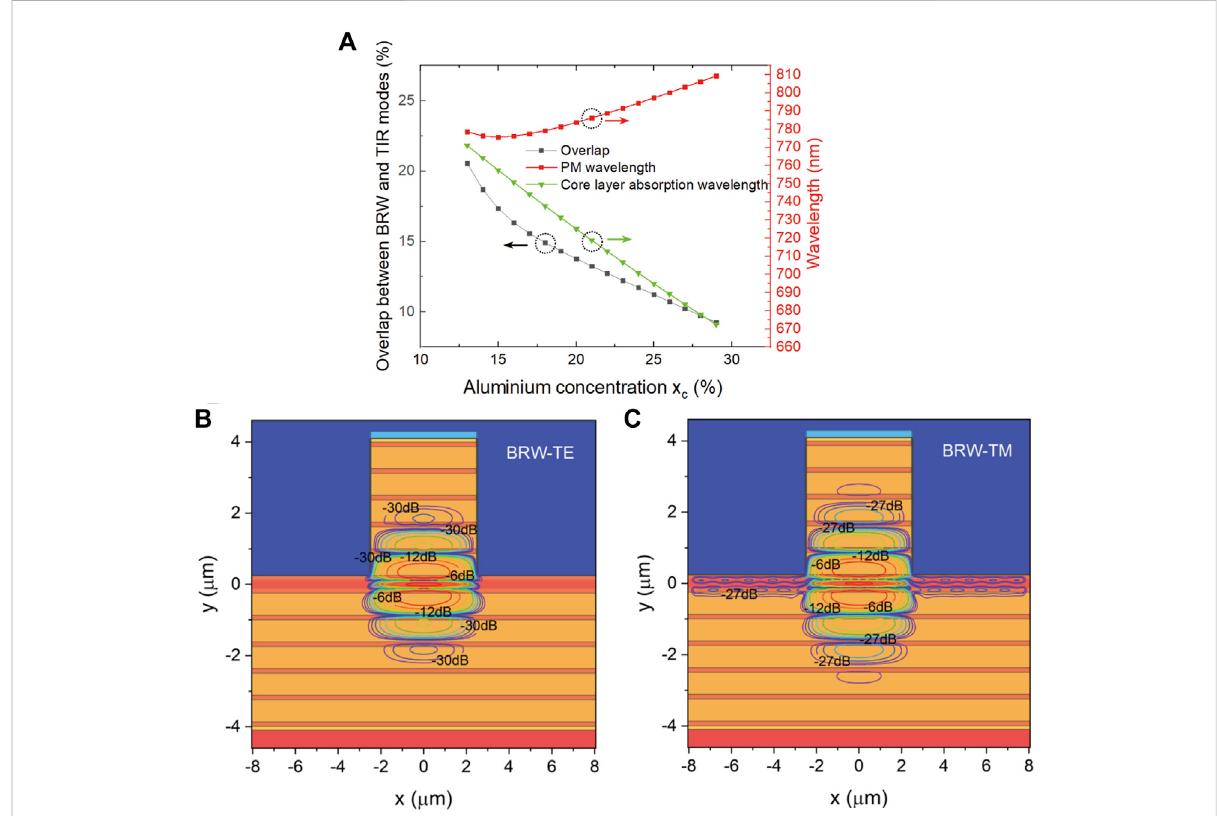
power as a function of FL wavelength. As the results shown in Figure 3A, when the FL wavelength is tuned to 1,580.6 nm, a maximum SHG output power of 4.029 pW is obtained.